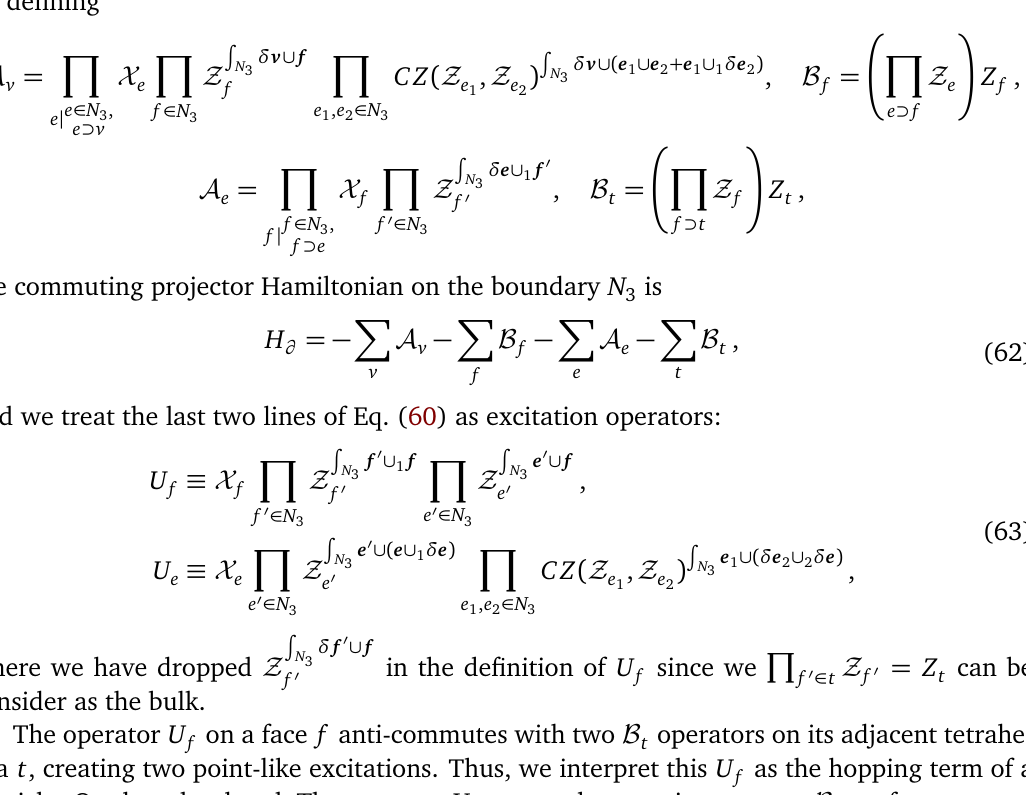
Figure 4: It can be checked that for any set of faces f is always a minus sign in U U is the hopping operator of a fermionic f